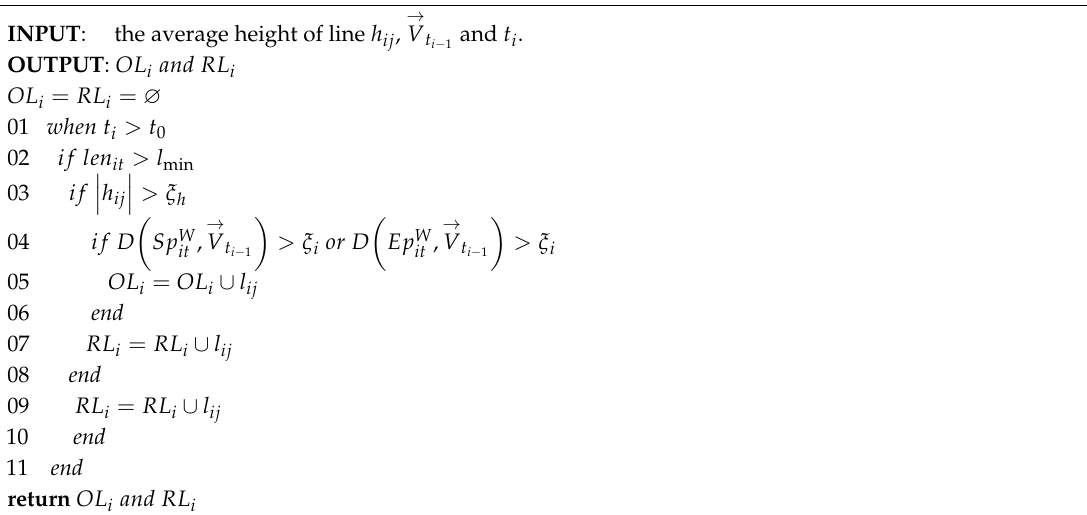
Algorithm 3: Obstacles extraction.